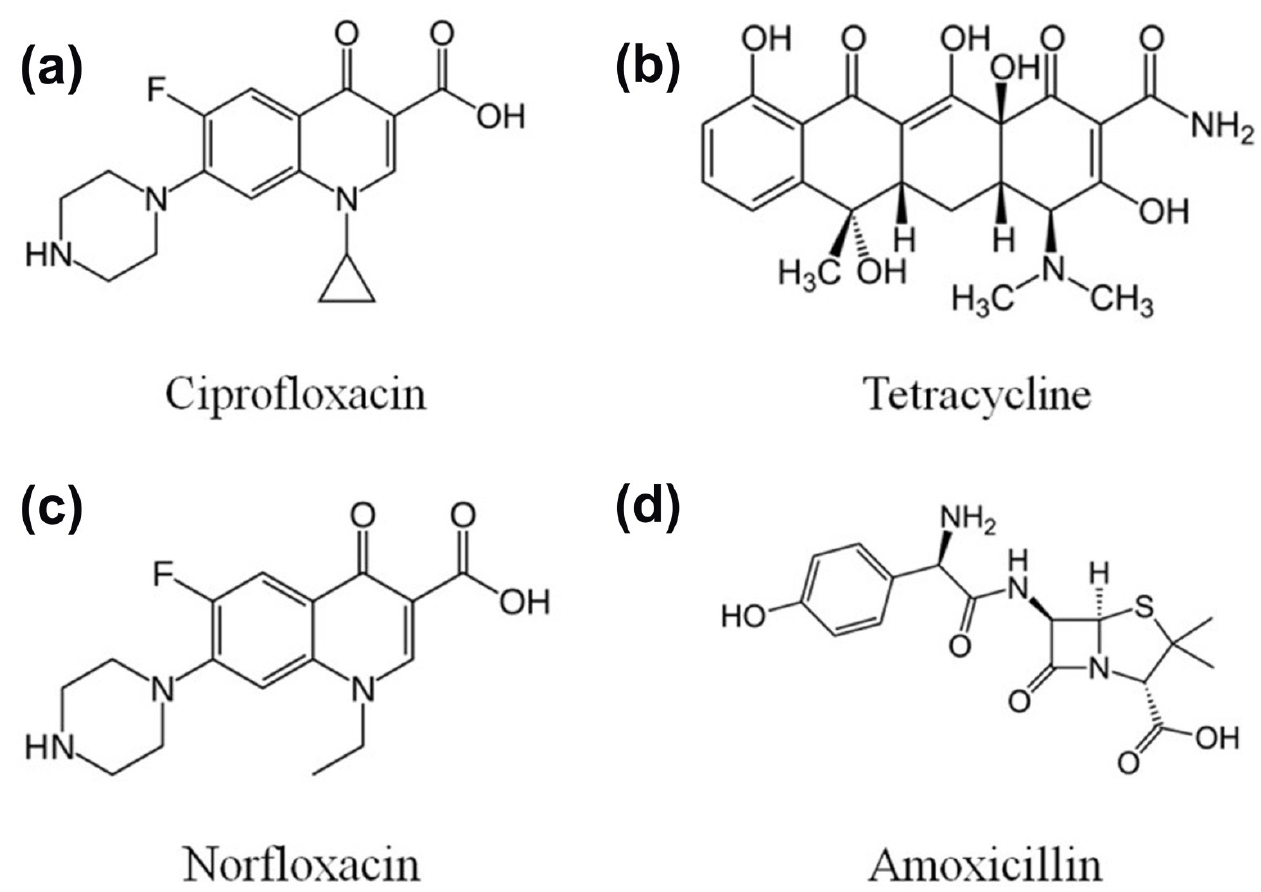
Figure 6. The illustration of commonly investigated antibiotics in photocatalytic processes. ( a ) Ciprofloxacin. ( b ) Tetracycline. ( c ) Norfloxacin. ( d ) Amoxicillin. (Reproduced with permission from [1], copyright 2021,